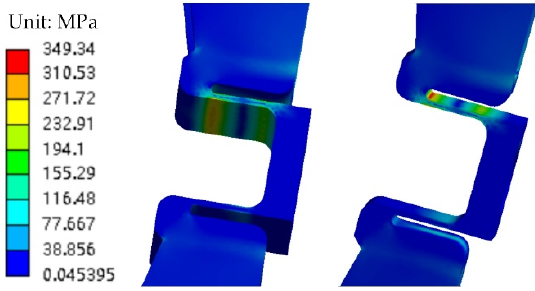
Figure 5. Stress distribution of the flexible hinges.